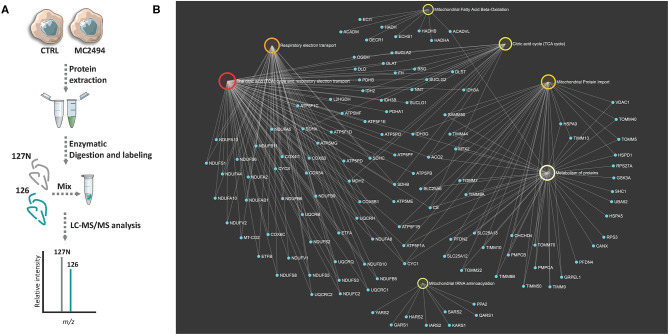
(A) Schematic workflow used for TMT-based quantitative analysis of mitochondrial proteome of MC2494-treated vs. untreated U937 cells. (B) Bipartite view of enrichment network including selected significant Gene Ontology (GO) categories and related identified mitochondrial proteins. Up- and down-regulated nodes are depicted in red and green, respectively, based on their log2 fold change values. Nodes are colored according to their p-value. The size of the node corresponds to the number of proteins in the list mapped on the specific term. The smaller nodes in light blue correspond to individual proteins/genes.